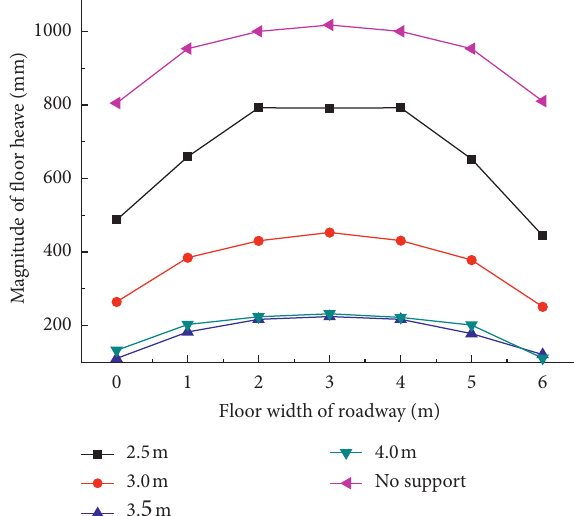
Figure 6: The magnitude of floor heave under different pile length.